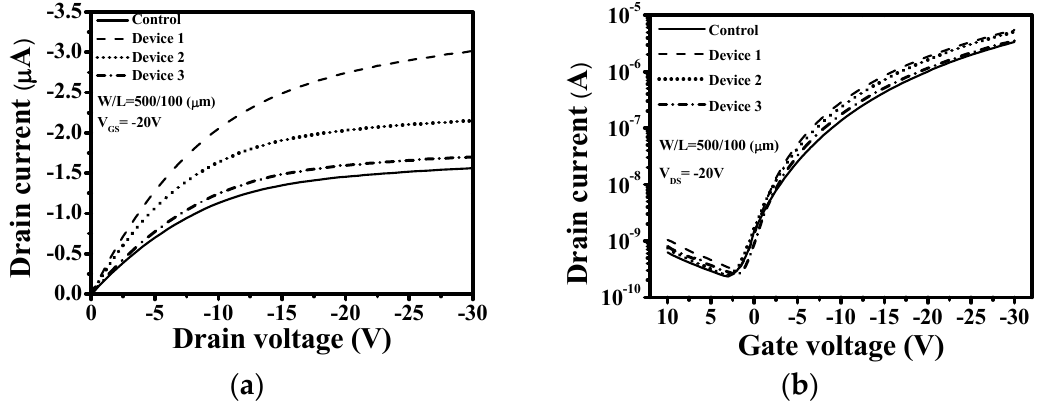
Figure 2. Drain current characteristics of top ‐ contact (TC) pentacene ‐ based OTFTs with different F 4 TCNQ:pentacene ratios (Device 1 = 1:1, Device 2 = 1:3, and Device 3 = 1:10) ( a ) Output curves ( I DS ‐ V DS ). ( b ) Transfer curves ( I DS ‐ V GS ).